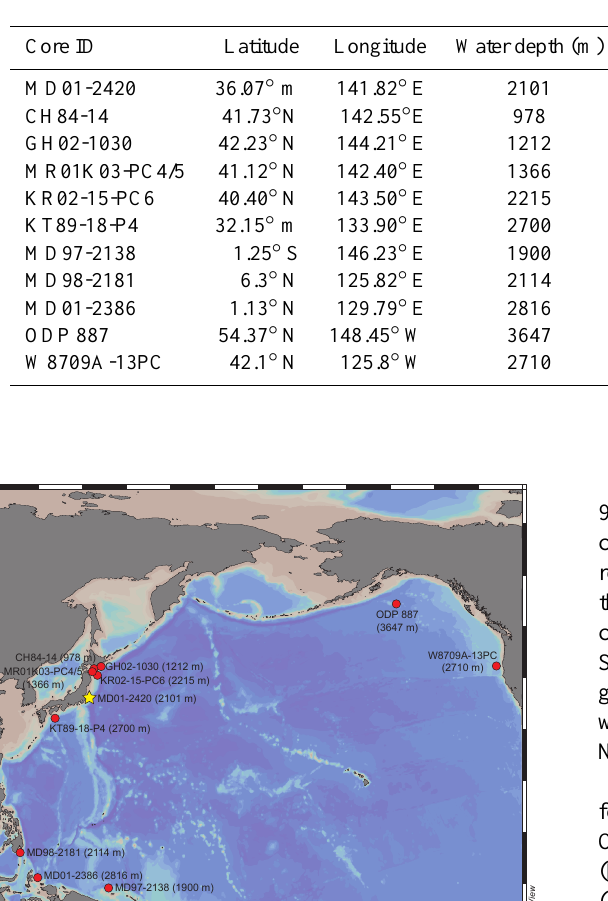
Table 1. Location of sediment cores and their 1 R in the North Pacific used in this study.